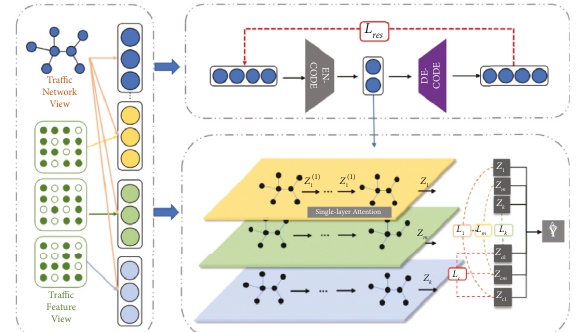
Figure 1: The end-to-end framework of proposed model. The MV- GAT model includes multi-view input, multi-layer attention module, and the autoencoder module. The node-level prediction results are obtained as